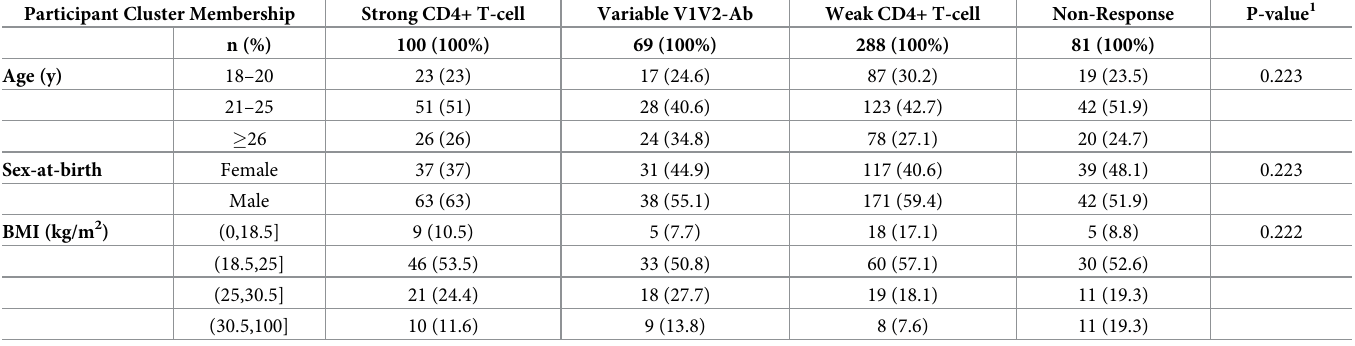
Table 2. Results from analyzing cluster membership with three demographic covariates (age, sex-at-birth and BMI), from 538 vaccine and placebo recipients in all three trials with 64 immune responses (shown in Fig 1). Participant Cluster